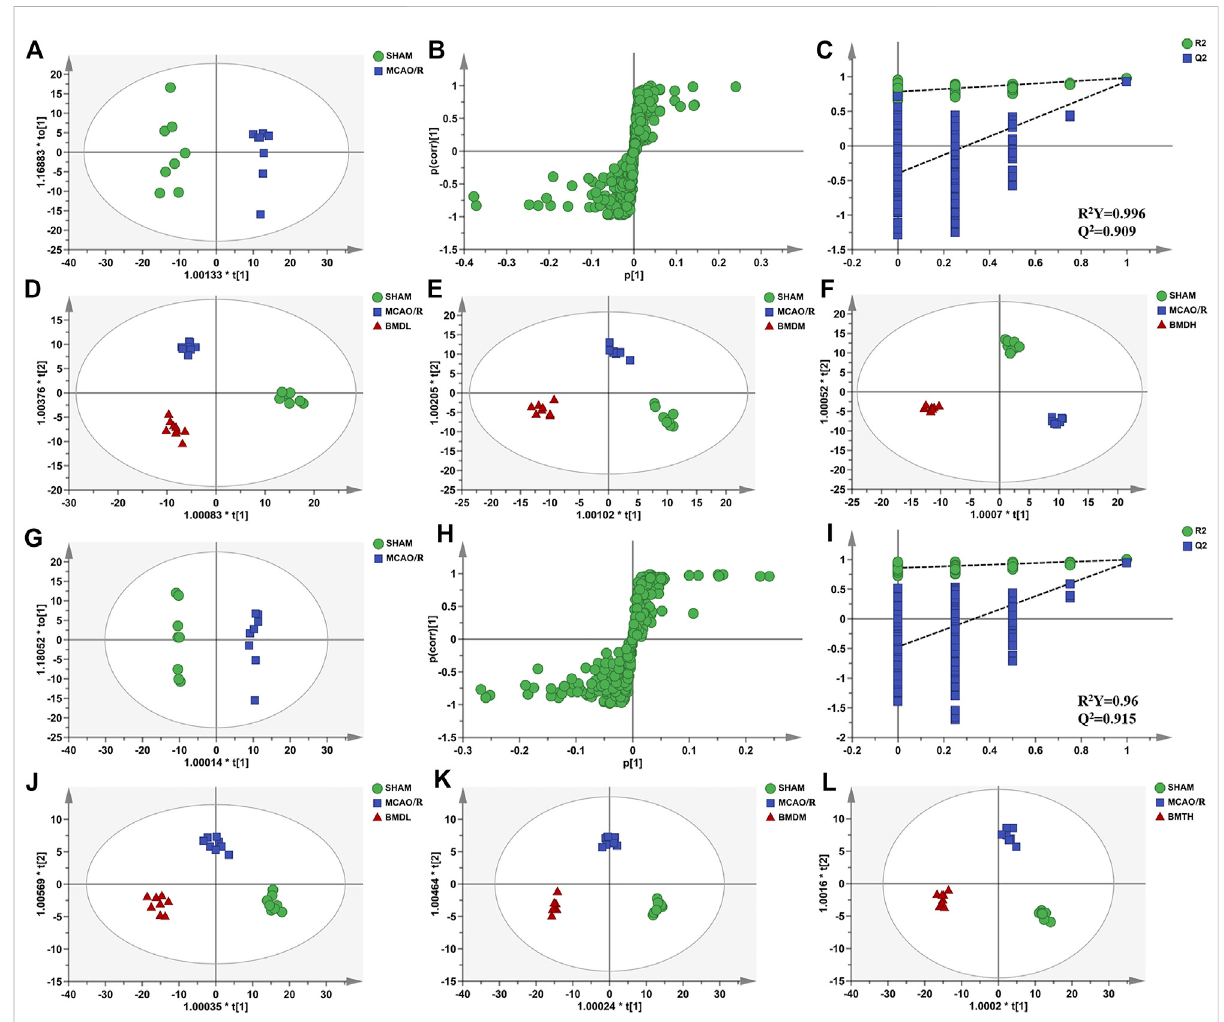
FIGURE 6 OPLS-DAscoreplots,S-plots,andpermutationvalidationofserumsamples. (D – F) OPLS-DAscoreplotsofSHAM,MCAO/R,BMDL,BMDM,and BMDH in the positive mode; (J – L) OPLS-DA score plots of SHAM, MCAO/R, BMDL, BMDM, and BMDH in the negative mode; (A,G) OPLS-DA score plots of SHAM and MCAO/R in positive and negative modes, respectively; (B,H) S-plots of SHAM and MCAO/R in positive and negative modes, respectively; (C, I) permutation validation of SHAM and MCAO/R in positive and negative modes, respectively ( n =